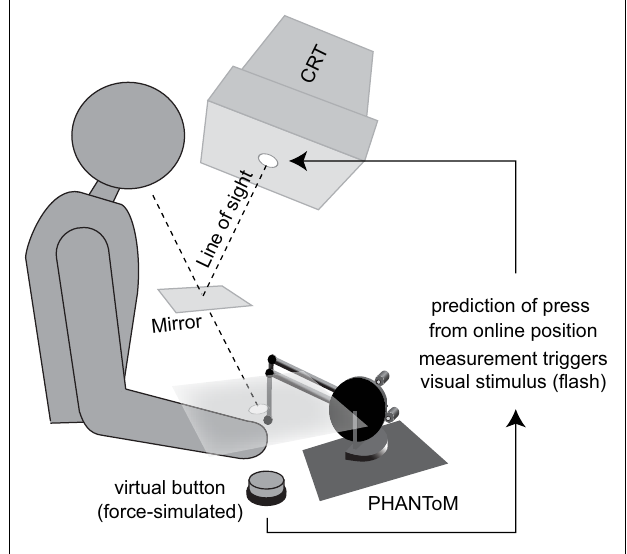
FIGURE 1 | Schematic of the experimental